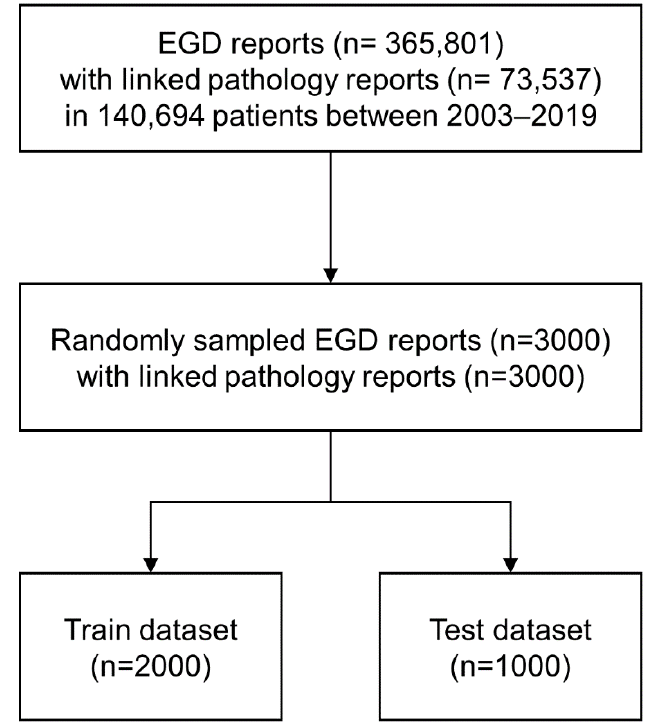
Figure 1. Data flow chart of the study. EGD: esophagogastroduodenoscopy.